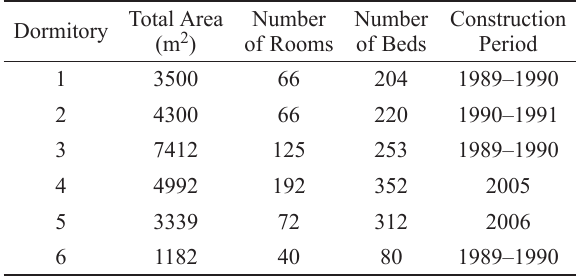
Table 1. Information about the dormitories